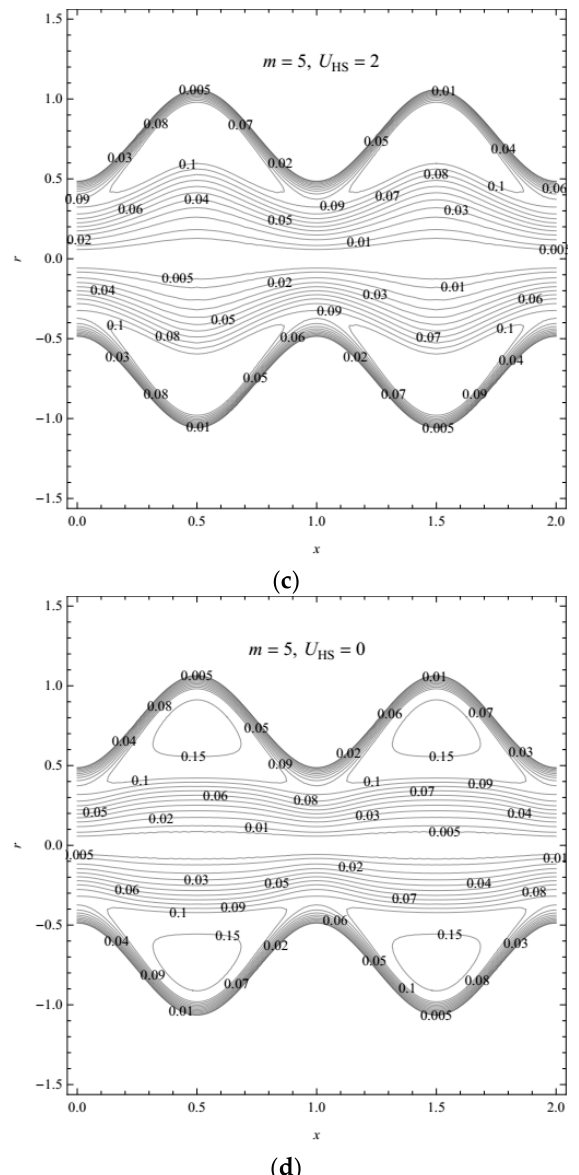
Figure 8. Profiles of the stream function for different values of m and U HS : ( a ) m = 1, U HS = 1; ( b ) m = 5, U HS = 1; ( c ) m = 5, U HS = 2; ( d ) m = 5, U HS = 0 with fixed α = 0.4, β = 0.6, λ 1 = 1, λ 2 = 1, φ = 0.6, t =